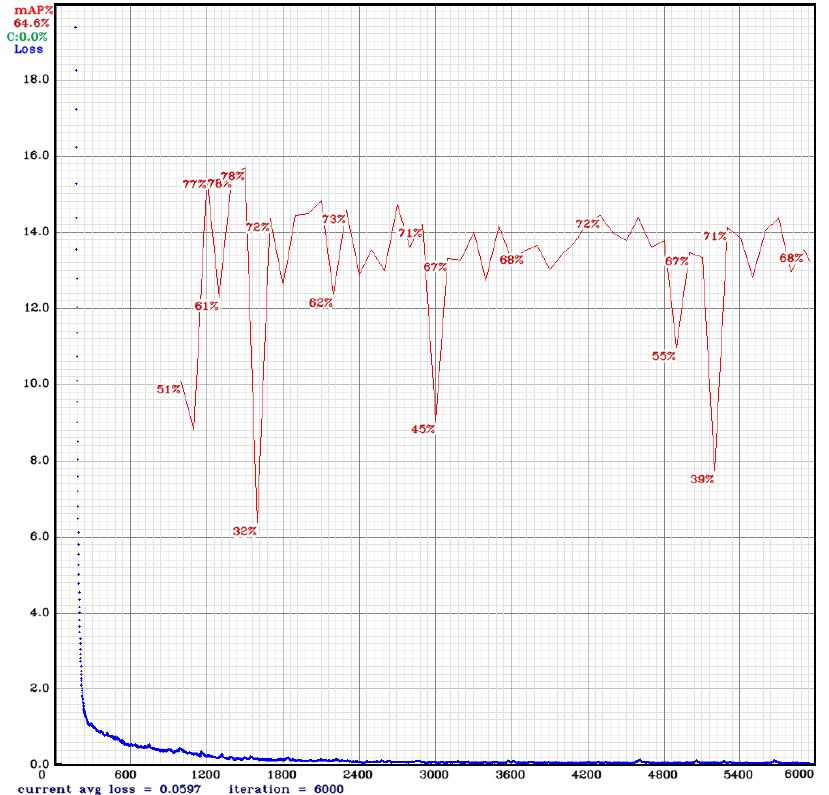
Figure 10. The progress of the loss value while training the approach proposed by Behera and Bazil [42]. On the other hand, yolov4 was trained on the same dataset, and the progress of the evaluation criteria is depicted in Figure 11. As shown in the figure, the progress achieved by yolov4 for the mAP was much better than the corresponding progress achieved by yolov3. The best mAP value achieved by yolov4 was 89.9 for the training set and, overall, the training epochs. In addition, the best average loss value achieved by yolov4 was 0.5360, which is higher than the corresponding value achieved by yolov3. However, the effects of these values can become apparent when we check the generalization of these